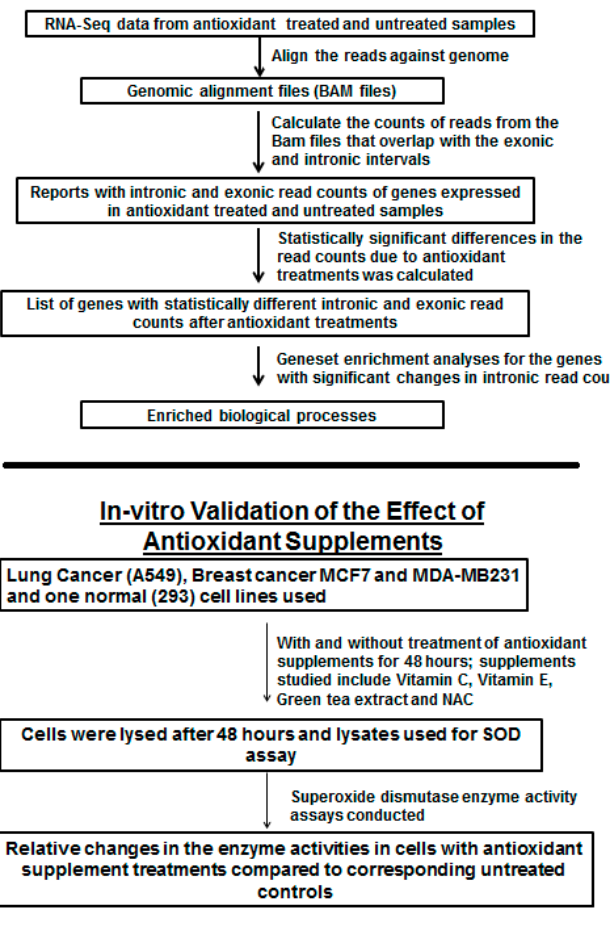
Figure 1. Experimental strategy.